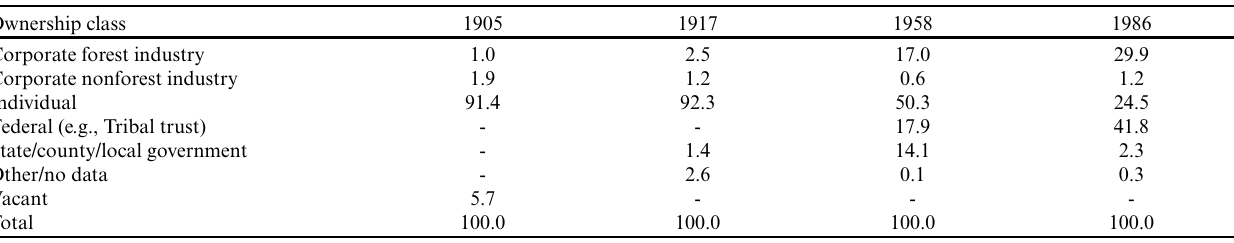
Table 1. Land ownership composition (percentage) of the Bad River Indian Reservation zone of the Lake Superior clay plain study area at four times states: 1905, 1917, 1958, and 1986. The Lake Superior clay plain study area comprises 62.9% of the